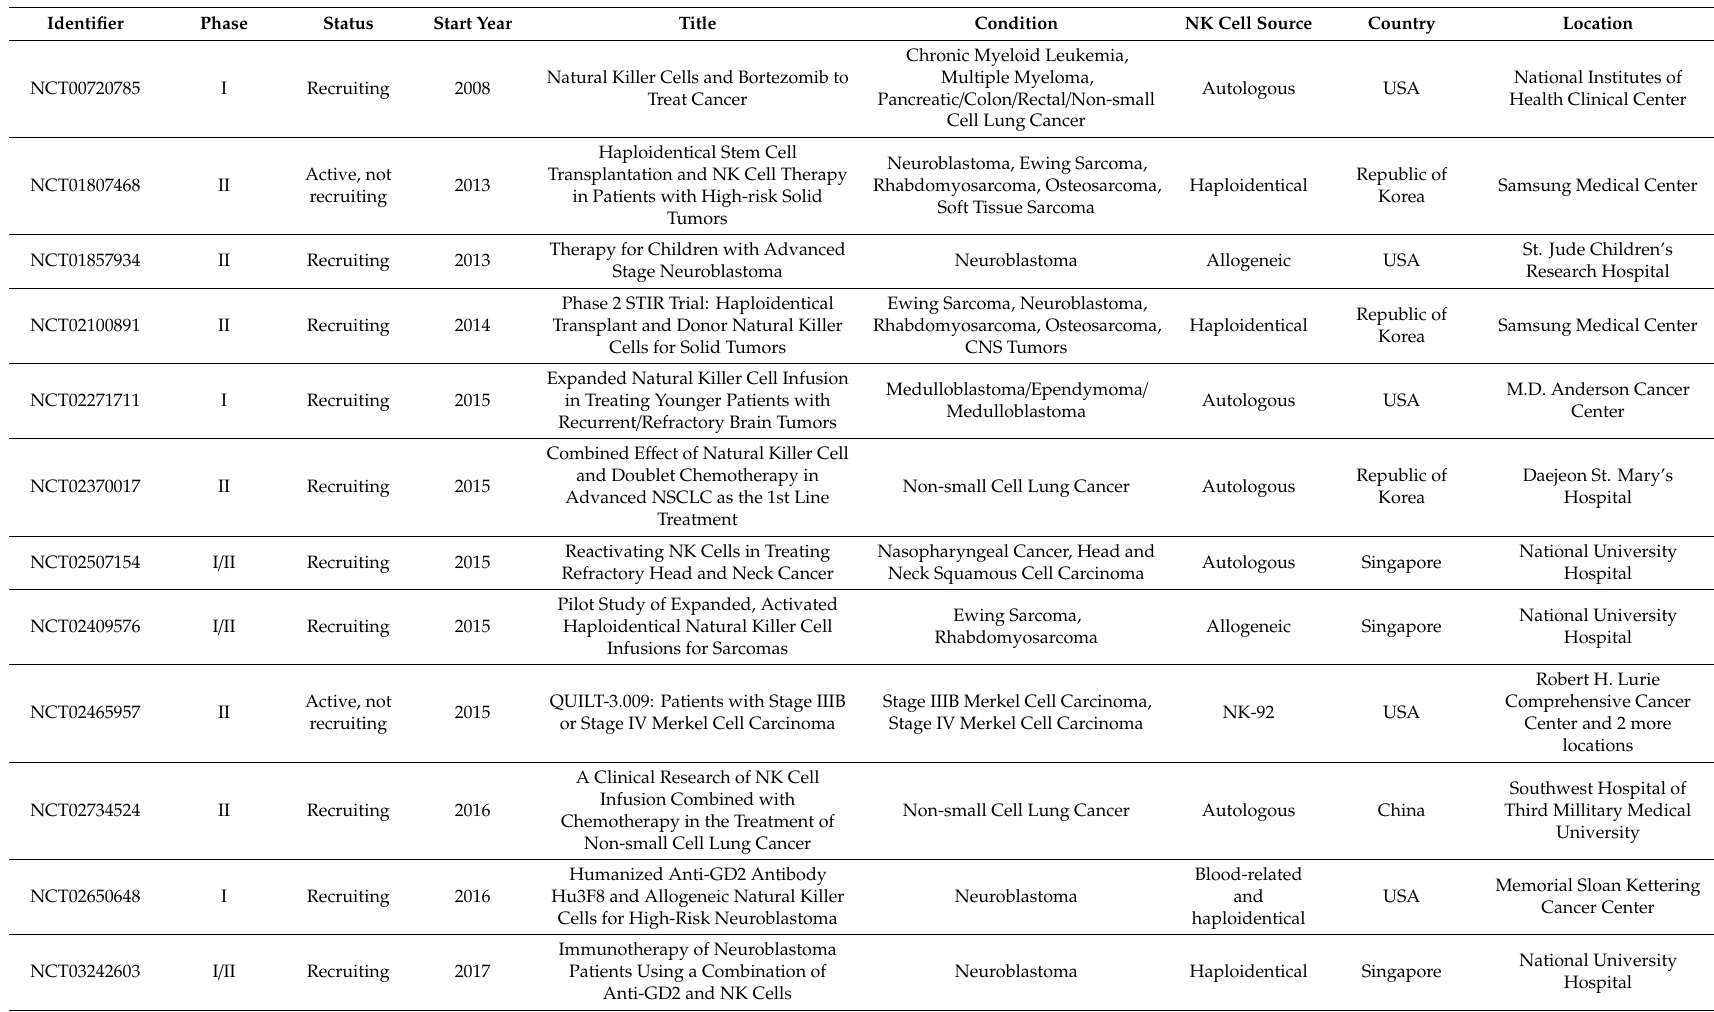
Table 1. On-going clinical trials on natural killer (NK) cell therapy for solid